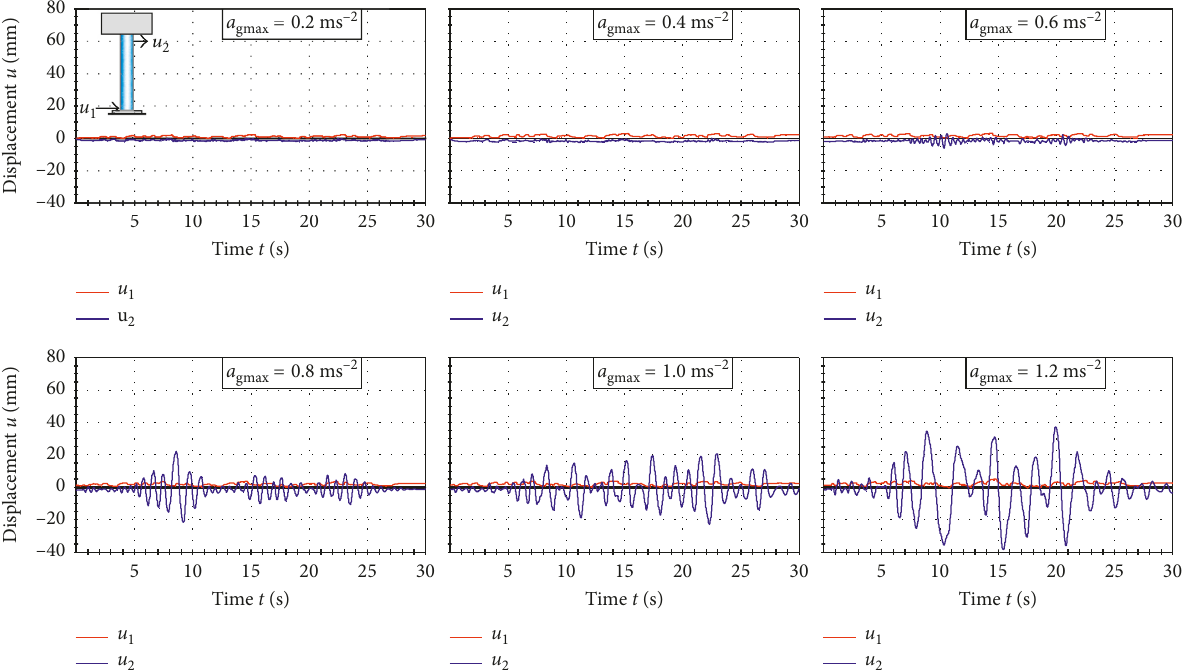
Figure 8: Horizontal displacements u 1 and u 2 of the column S1m for the artificial accelerogram at some a gmax